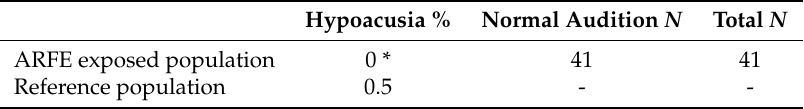
Table 2. Contingency table to compare the prevalence of diagnosis of hypoacusia in the sample of the study and the reference population. * A syndromic case was excluded, according to the criteria of the study.